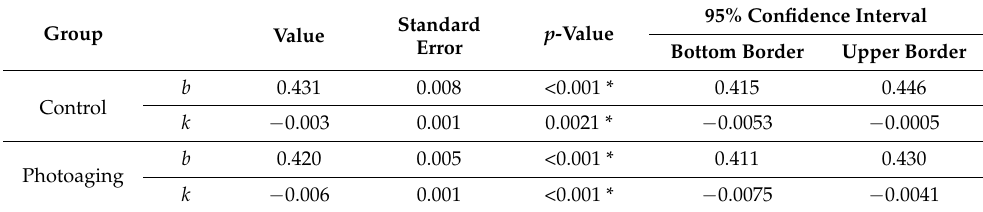
Table 2. Linear regression equation coefficients η collagen (t)